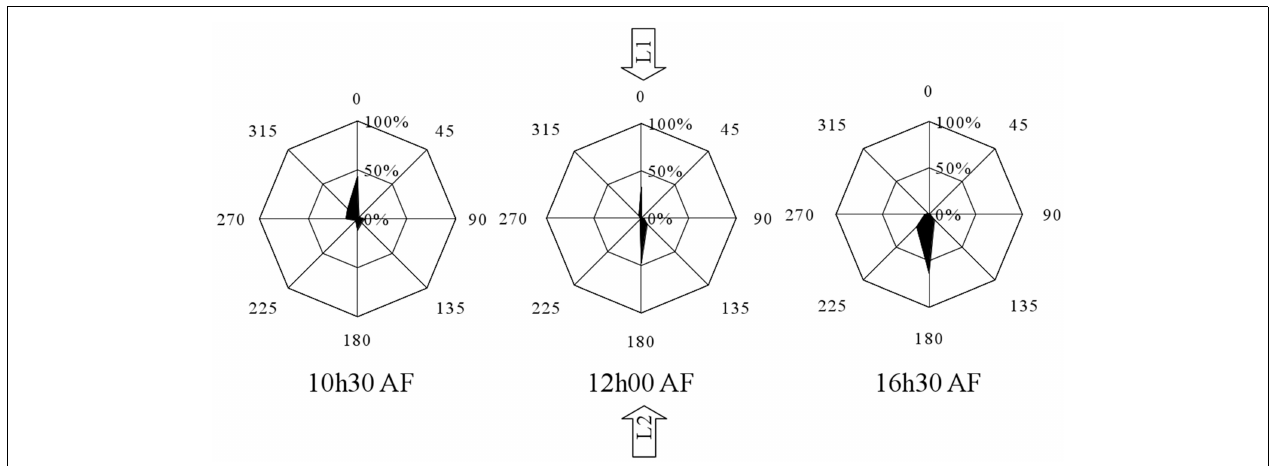
angularorientationofrhizoidoutgrowthrelativetothecenterofthecell.Angles represent the relative orientation of the rhizoid relative to the orientation of the first unidirectional light source ( n = 300 in three replicate